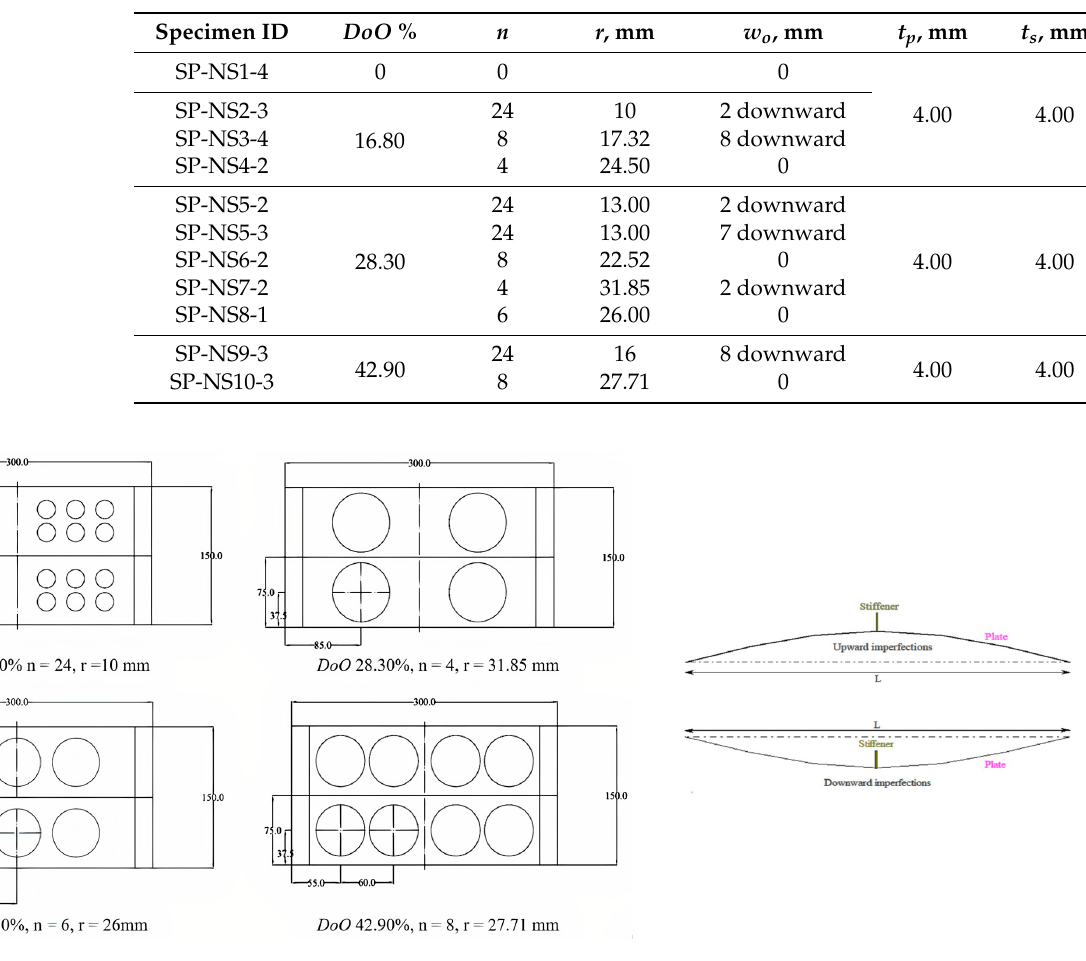
Figure 1. Geometrical configurations of perforated specimens. Table 1. Structural configurations of perforated stiffened plates.